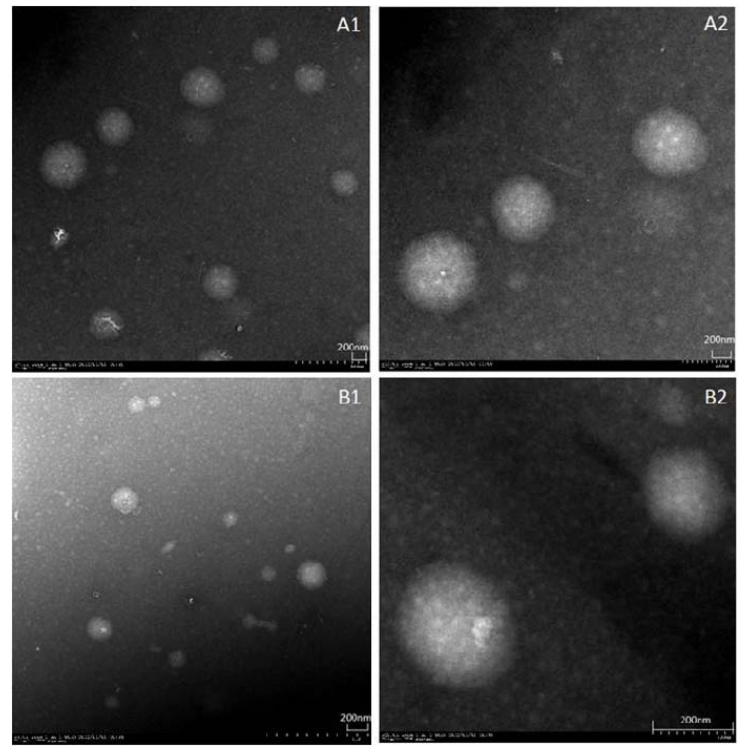
Figure 2. TEM figures of the self-assembled nanomicelles: ( A ) icariin + DOC (A1: ×5.0 K; A2: ×20.0 K); ( B ) icariin + DOC + suet oil (B1: ×7.0 K; B2: ×12.0